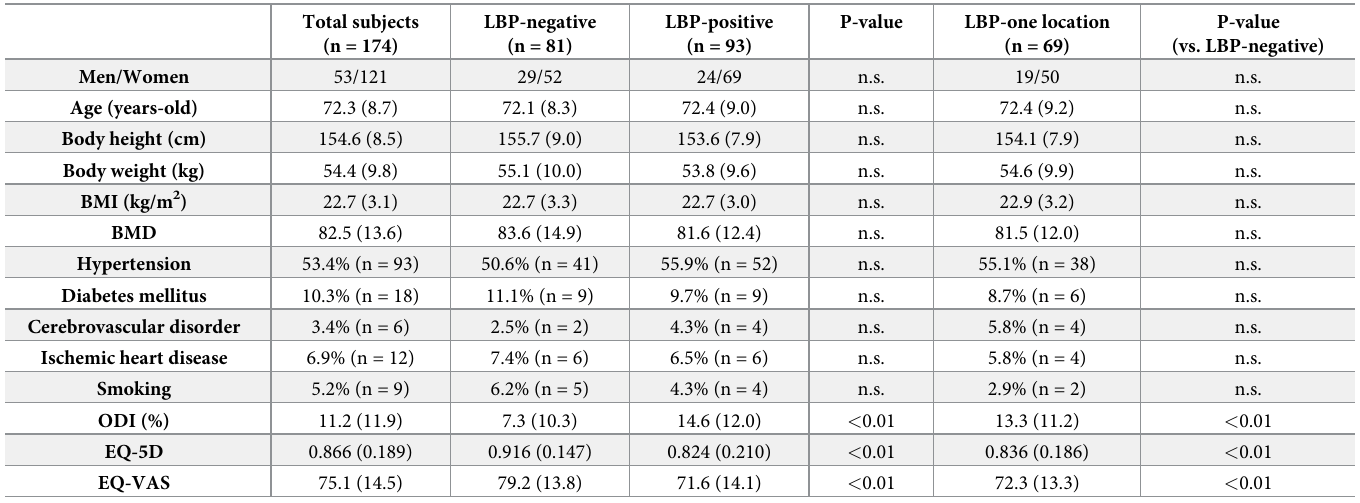
Table 1. Characteristics of subjects with or without low back